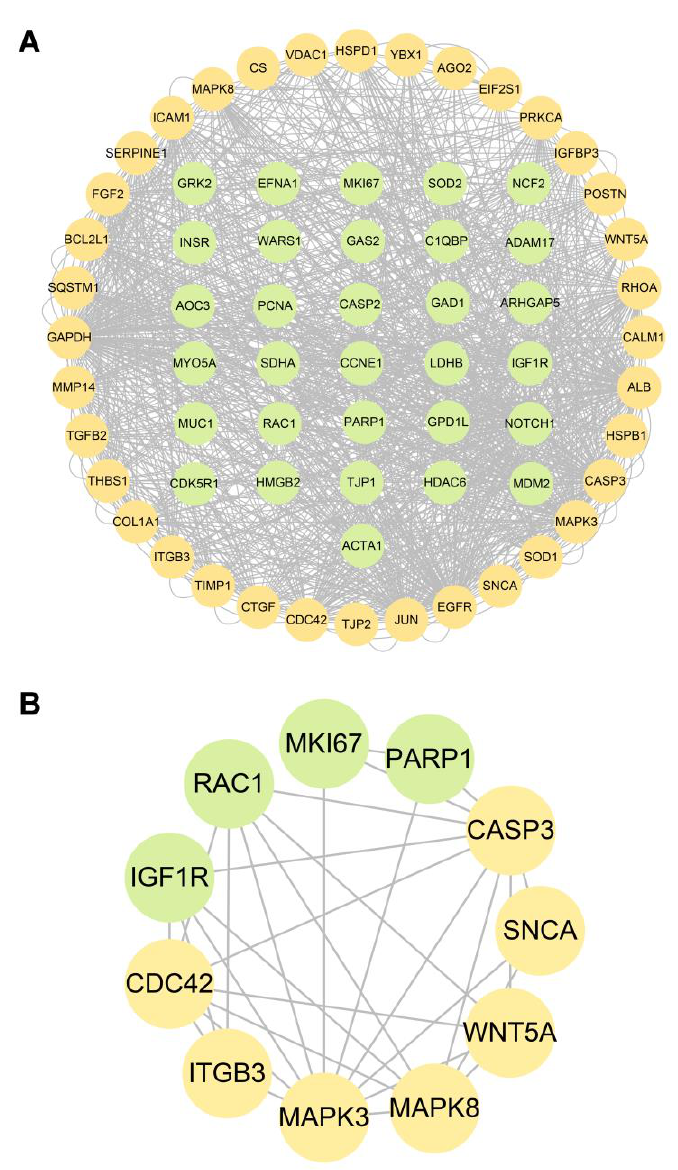
Figure 8. PPI network between AAD-related CIP targets and hub genes of CIP-stimulated DEPs. ( A ) PPI network. ( B ) Gene cluster module. Green nodes: AAD-related CIP targets. Yellow nodes: hub genes among the genes encoding CIP-stimulated DEPs.